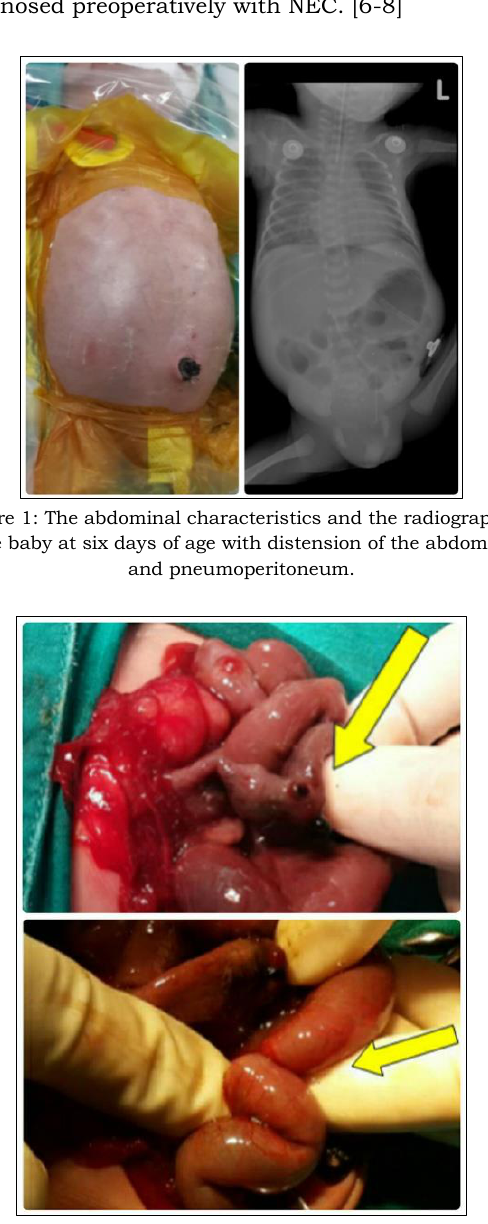
Figure 2: Perforation Site (arrow, upper frame) and Ileo-leal Intussusception (arrow, lower